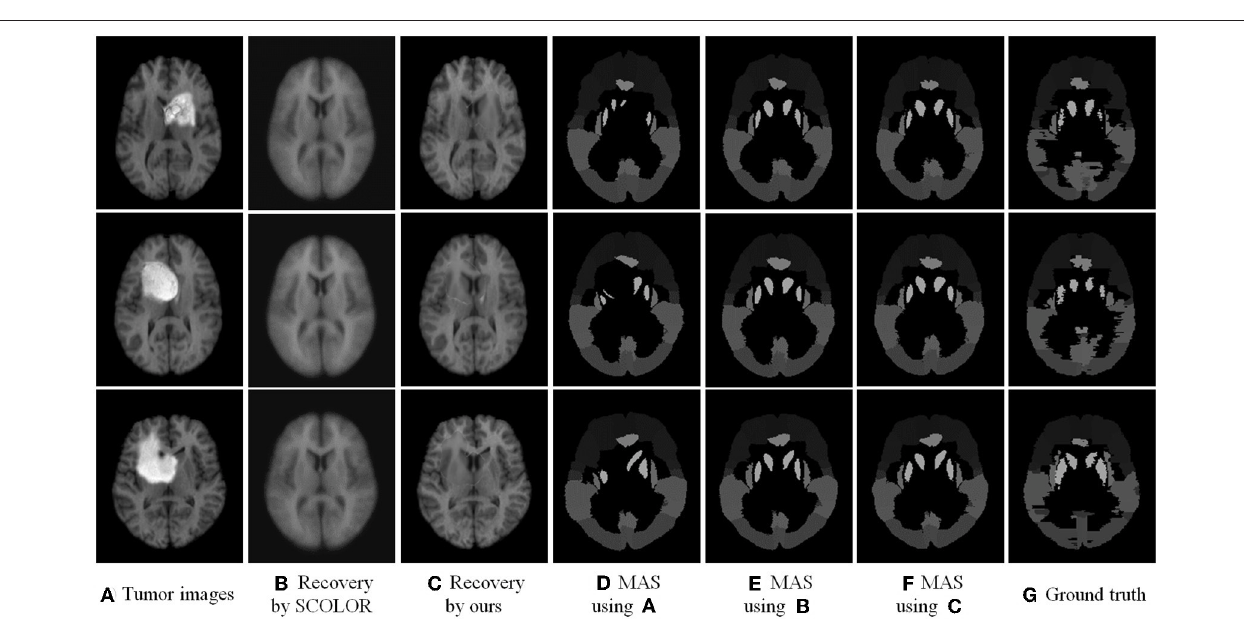
FIGURE 8 | Multi-atlas segmentation results: (A) brain tumor images, (B) the recovered images by SCOLOR method, (C) our recovered images with quasi-normal brain appearances, (D) the MAS results by using original tumor images, (E) the MAS results by using the recovered images from SCOLOR, (F) the MAS results by using our recovered images, and (G) the segmentation ground